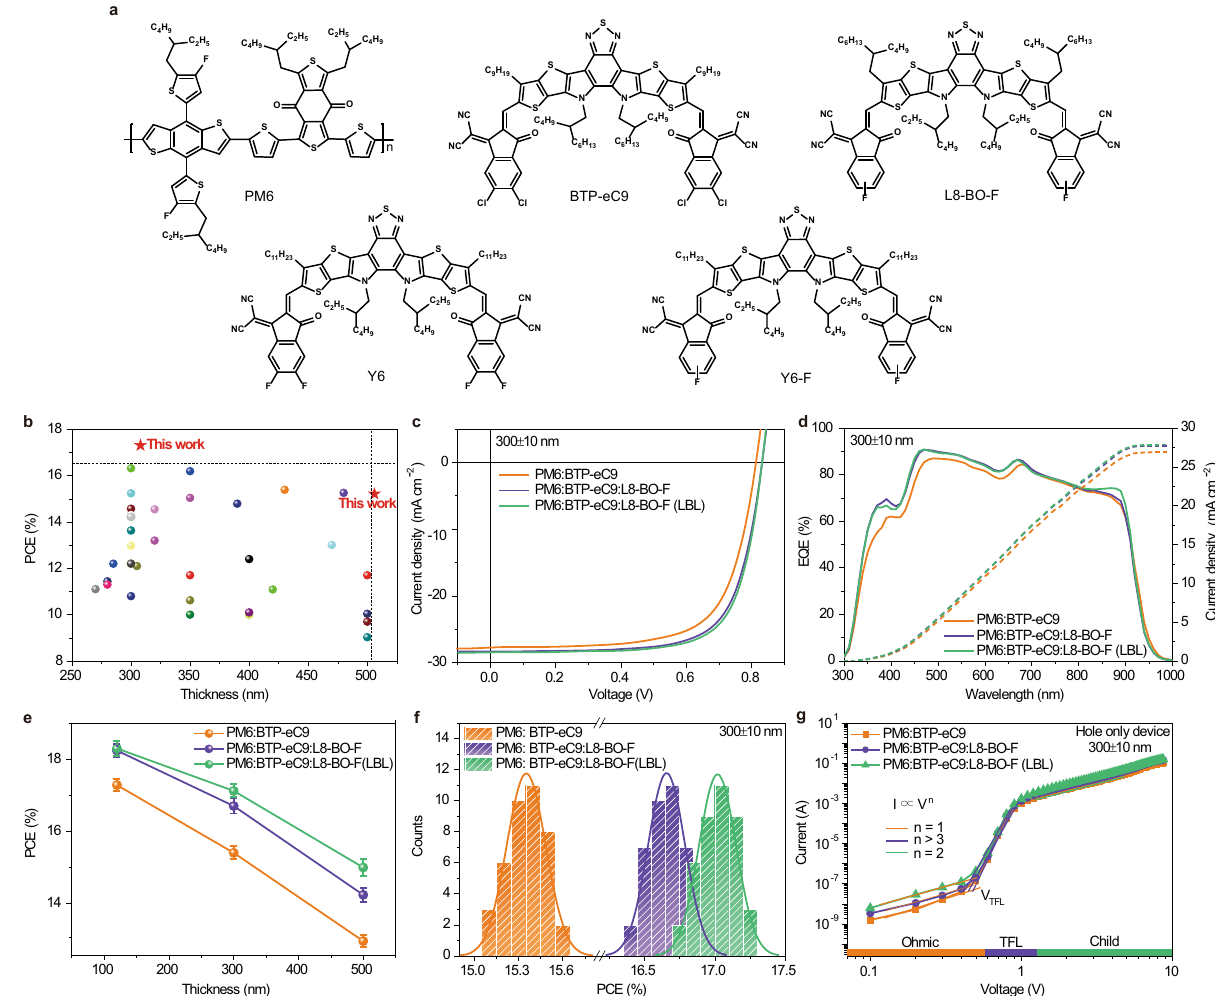
Fig. 1 Molecular structures, photovoltaic performance and mobilities. a Molecular structures of donors and acceptors used in this work. b Plots of the PCE versus active layer thickness for different systems. c Current – voltage ( J – V ) characteristics of the PM6:BTP-eC9 and PM6:BTP-eC9:L8-BO-F devices with 300 nm active layer thickness under simulated AM 1.5 G illumination at 100 mW cm − 2 . d EQE spectra (solid lines) and integrated J sc s (dashed lines) of the binary and ternary devices. e Dependence of PCEs on the active layer thicknesses (the error bars represent the standard deviations). f Histogram of the PCE measurements for 40 devices based on the representative binary and ternary blends with 300 nm thickness. g I - V traces of the different blends with 300 nm thickness exhibiting three different regimes, marked with Ohmic, TFL, and Child, thin and thick devices were measured under continuous one sun illumination in air. As shown in Supplementary Fig. 8, 120 nm-, 300 nm- and LBL-processed 300 nm-thick ternary devices reached their T 80 (the time required to reach 80% of initial ef fi ciency) at 127, 138, and 152 h, respectively. The results indicate that the thick devices exhibit slightly improved photostability than the thin devices. The charge carrier mobility has been identi fi ed as a pivotal factor in thick- fi lm OSCs. The hole mobility ( μ h ) and electron mobility ( μ e ) of the active layers with different thicknesses were measured by the space charge limited current (SCLC) method (Fig. 1g and Supplementary Figs. 9 and 10), and the calculated mobilities are shown in Table 2. The device con fi guration of ITO/ PEDOT:PSS/active layer/MoO 3 /Al and ITO/ZnO/active layer/ PNDIT-F3N/Al were used to measure the μ h and μ e, respectively. With the increase of active layer thickness, the μ h and μ e of the binary and ternary devices are both improved, while the hole mobility increases more obviously (Supplementary Fig. 11). The μ μ h and e of LBL-processed ternary devices with 300 nm active layer thickness are 12.33 × 10 − 4 and 9.04 × 10 − 4 cm 2 V − 1 s − 1 ,